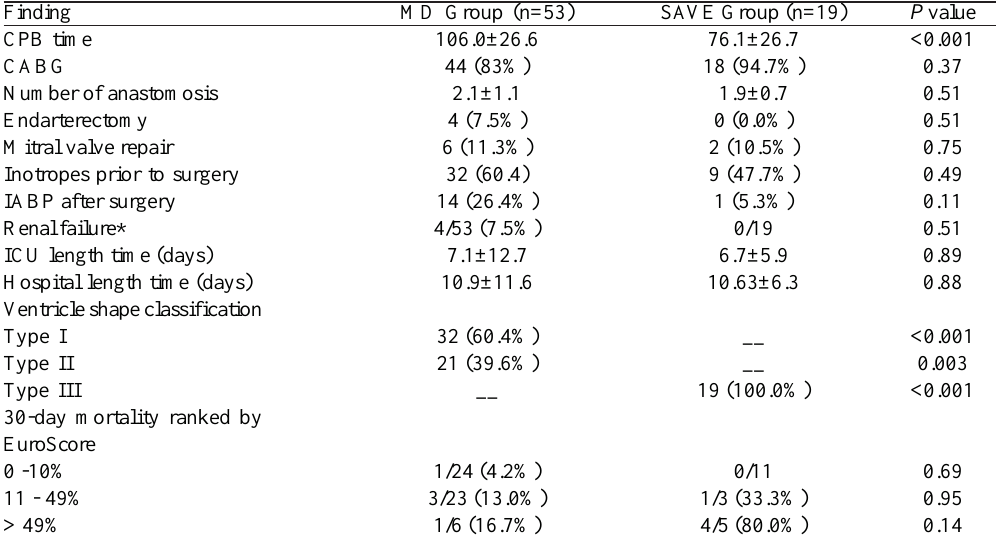
Table 3. Operative findings, perioperative variables and ranked mortality.